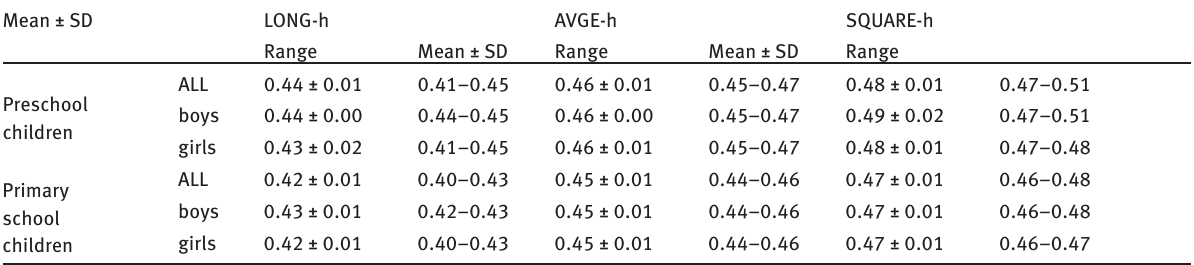
Figure 2: Comparison between dominant and non-dominant hand in Figure 1: Comparison between the HGS achieved using each handle the HGS. Box indicates mean, whereas the whiskers indicate position. Box indicates mean, whereas the whiskers indicate SD. Table 2 : Mean W/L ratios, standard deviations, and ranges for the hand shapes for the dominant hand in groups of participants.